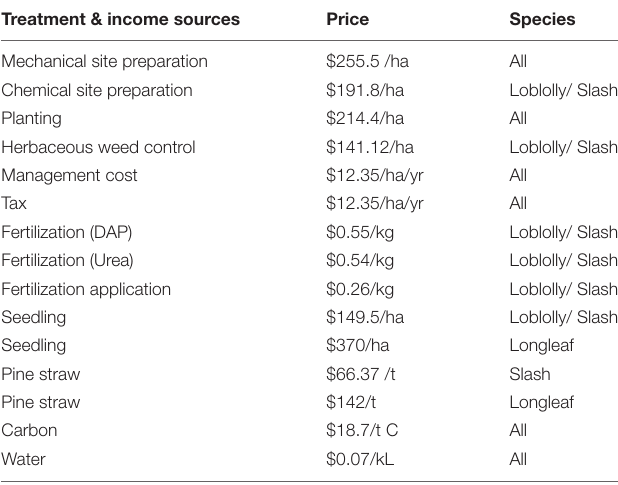
TABLE 4 | Parameters used for estimating costs and incomes for the management of selected pine